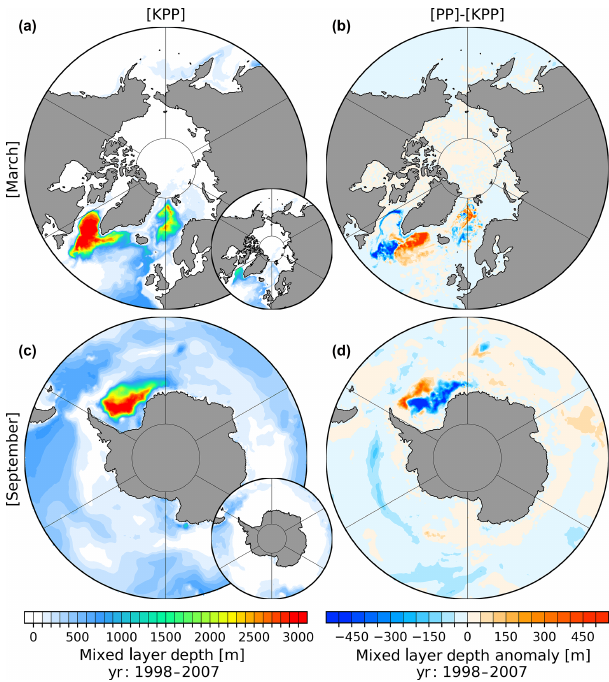
Figure 13. March (a, b) and September (c, d) MLD for the simu- lation with KPP (a, c) and PP (b, d) vertical mixing averaged over the period of 1998–2007. Small inset plots show the MLD after the definition of Large et al.